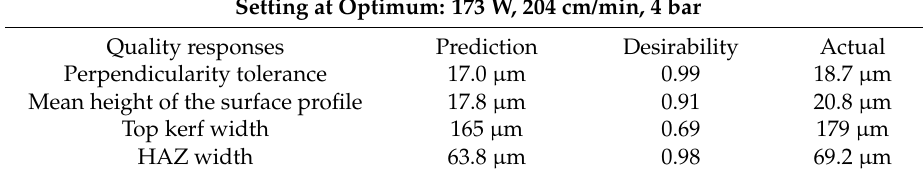
Table 9. Optimal condition minimizing the quality responses for laser cut hot stamping boron steel sheets: predicted and (average) actual values.